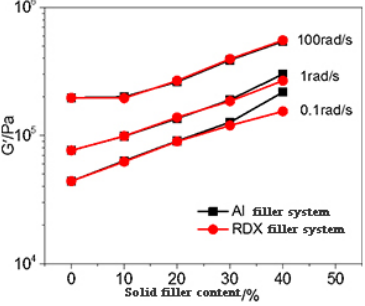
Figure 15. Relationship between G ′ of solid-filled model propellants and filler content at different angular frequencies.